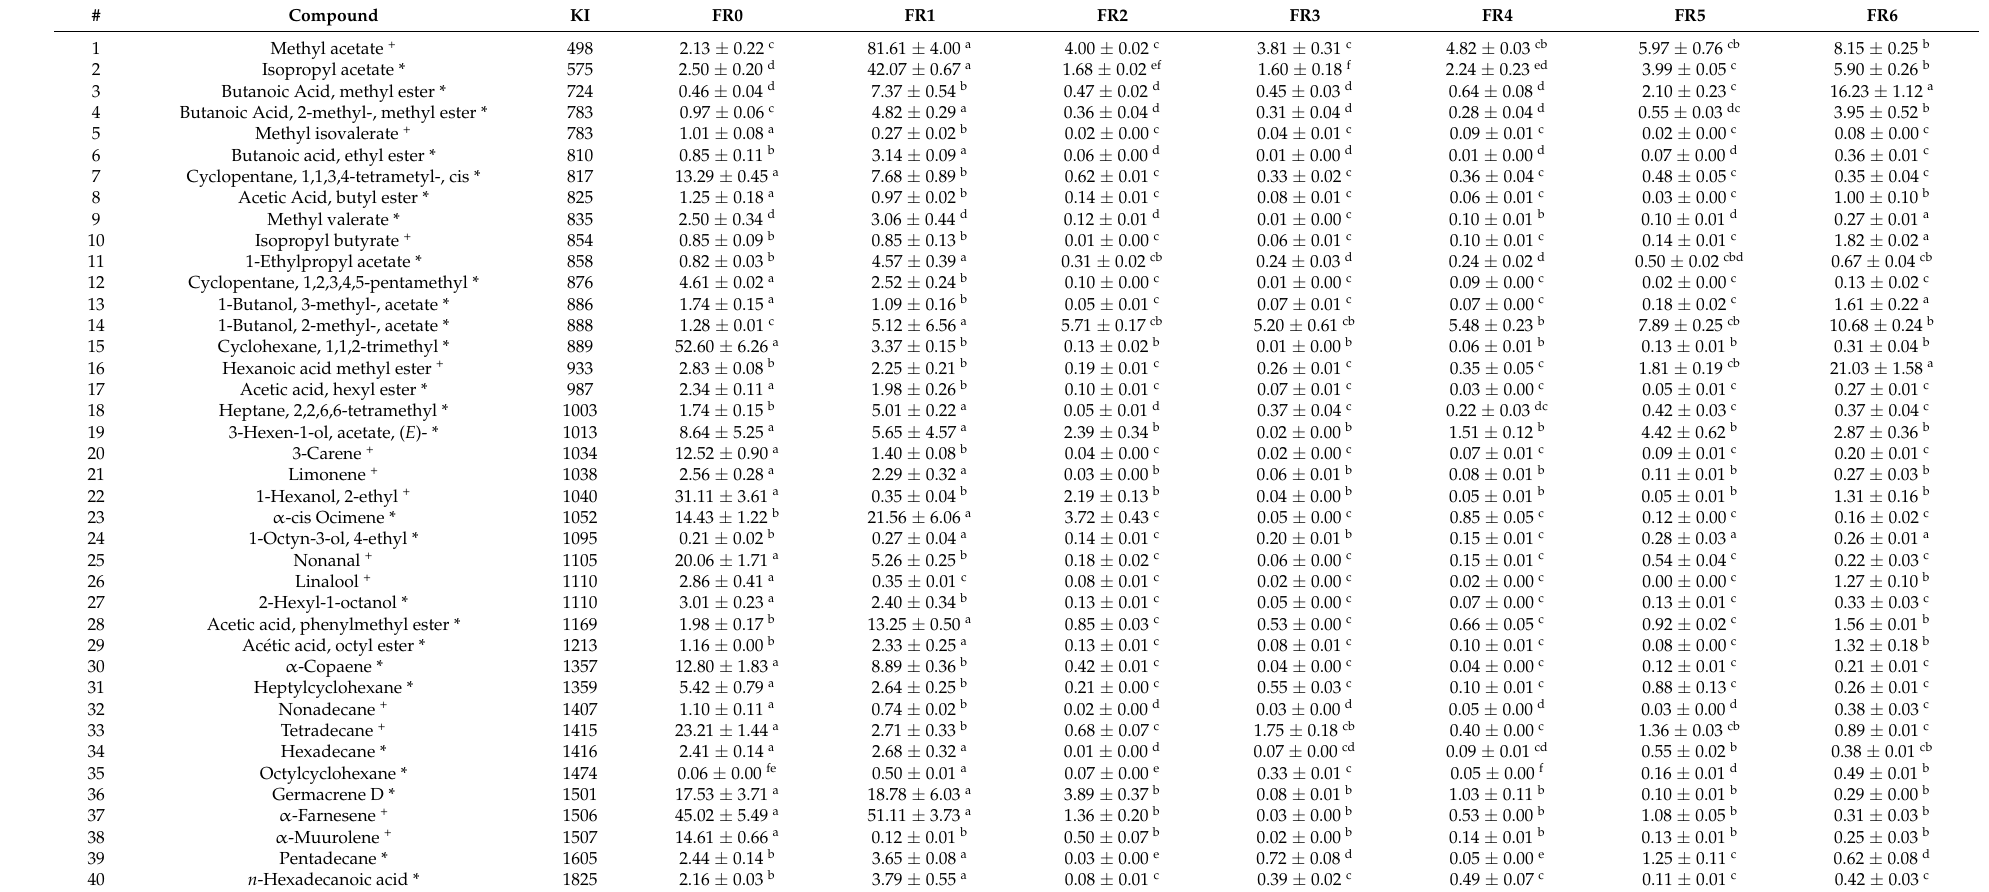
Table 3. Volatile organic compounds related to aroma in Frontera variety strawberries at seven stages of